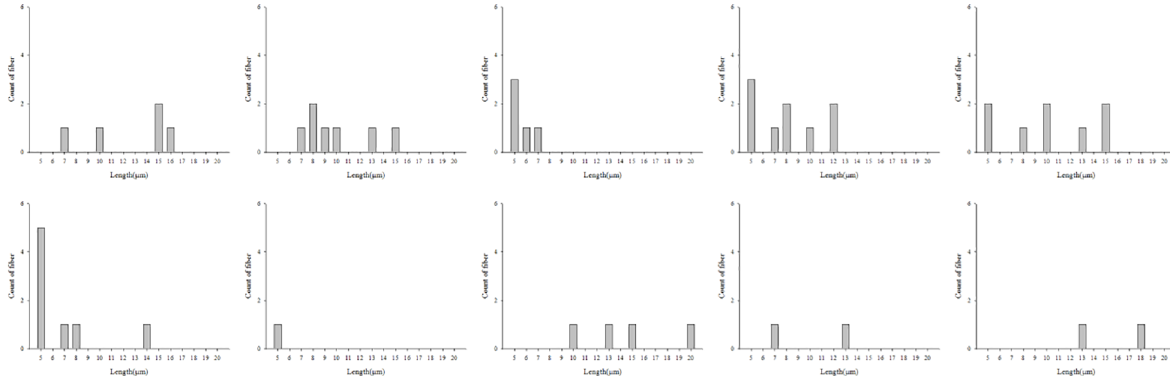
Fig 8. Length distribution according to applied voltage(serpentine type;